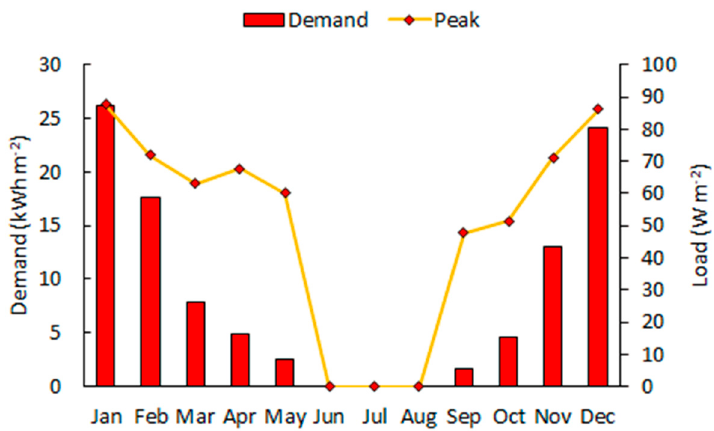
Figure 10. Monthly heating demand and peak loads.